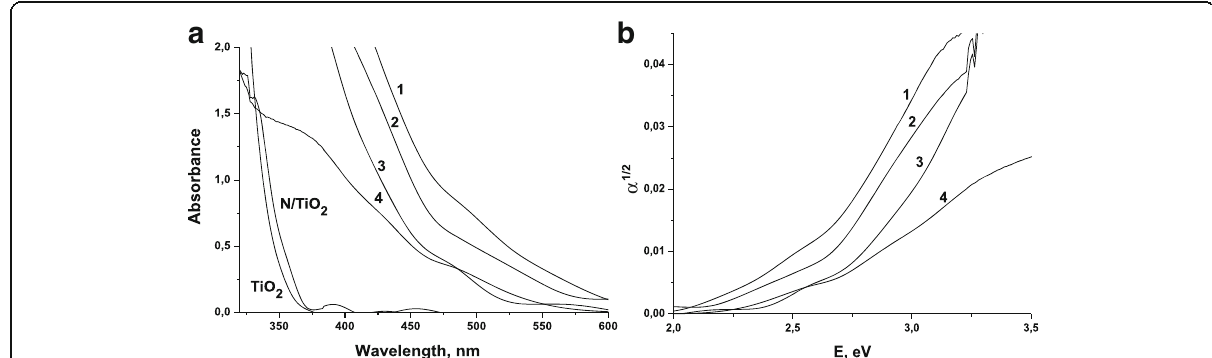
Fig. 2 Absorption spectra ( a ) and the plot of square root of absorption coefficient vs incident photon energy ( b ) 1 , Fe x Ti y O z 450; 2 , N/Fe x Ti y O z 450; 3 , Fe 4 , N/Fe x Ti y O z 500; x Ti y O z